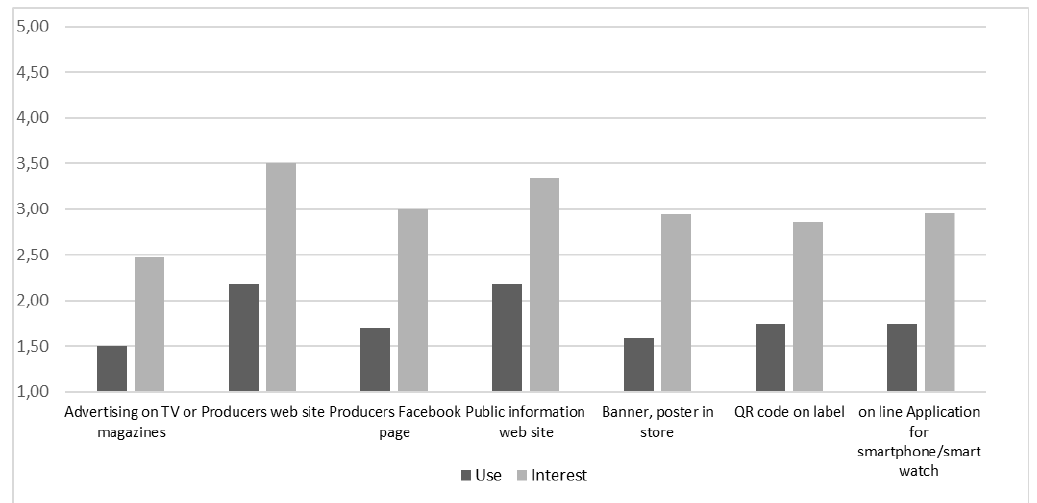
Figure 2. Participants’ use of and interest towards alternative sources for wine nutritional information.